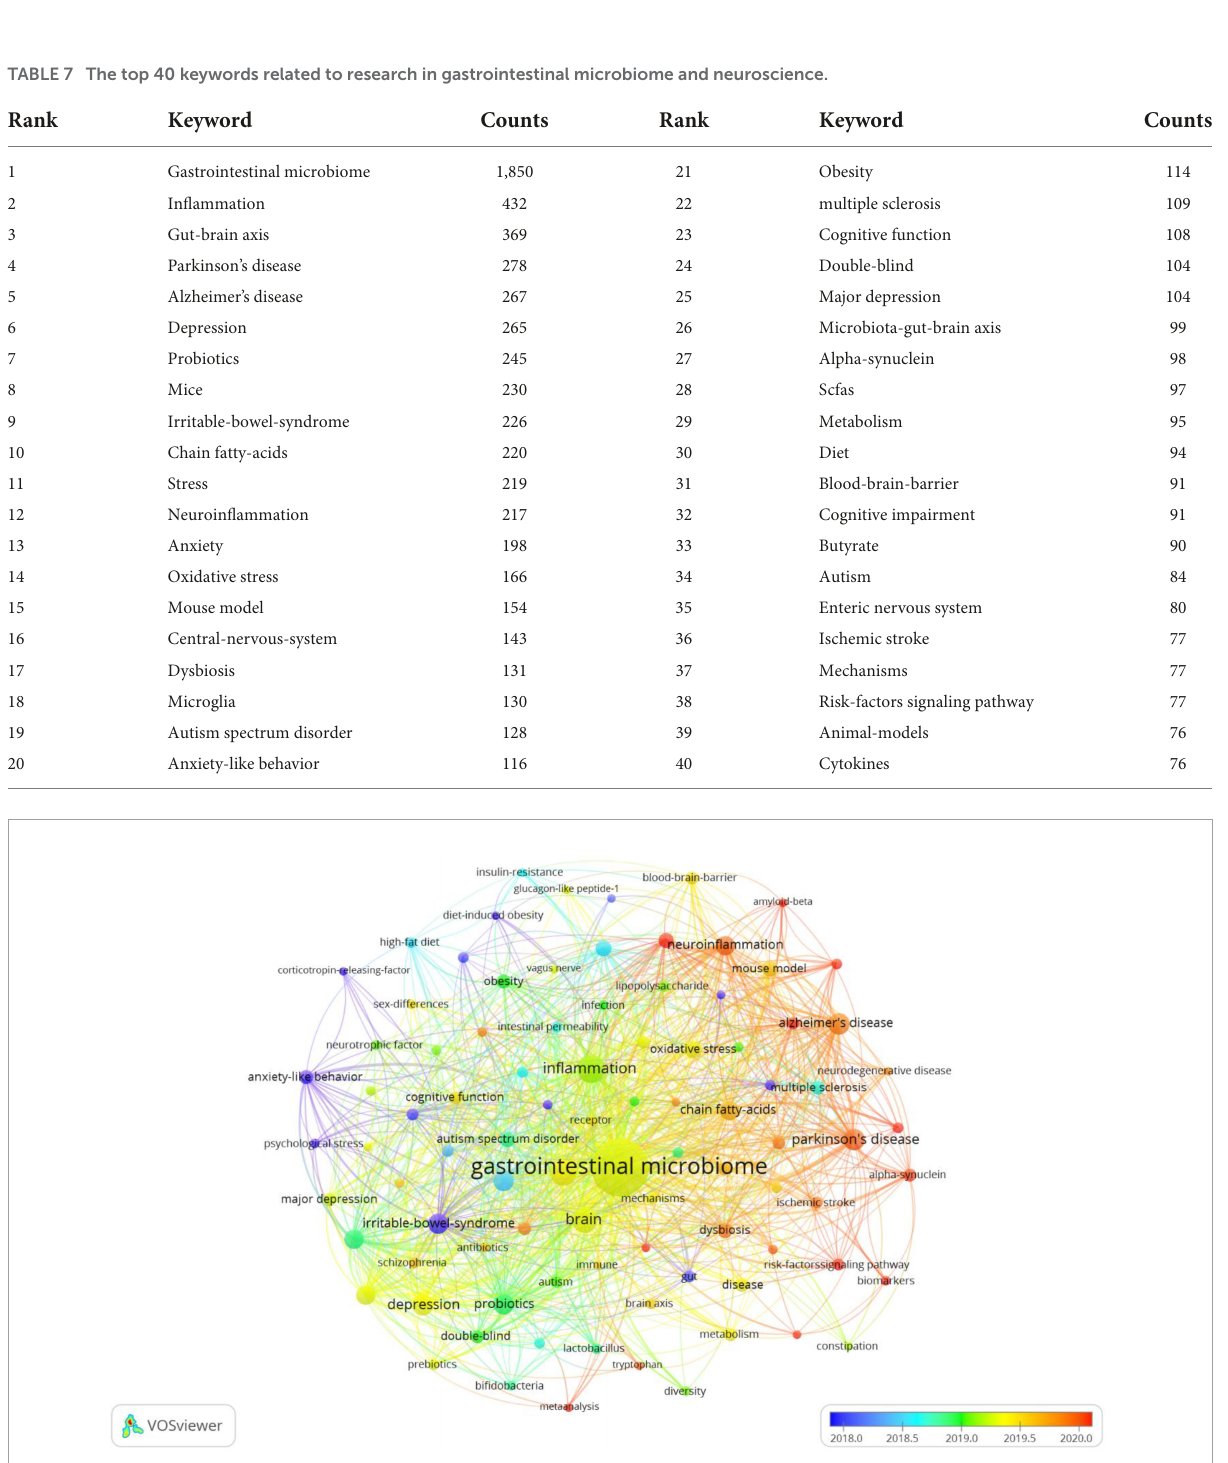
FIGURE7 The overlay visualization map of keywords in title/abstract fields of publications related to gastrointestinal microbiome and neuroscience. Different colors were applied for each keyword based on their average appearance time in the overlay visualization map. Blue color represented the keywords that appeared relatively earlier than those in yellow and red upon time